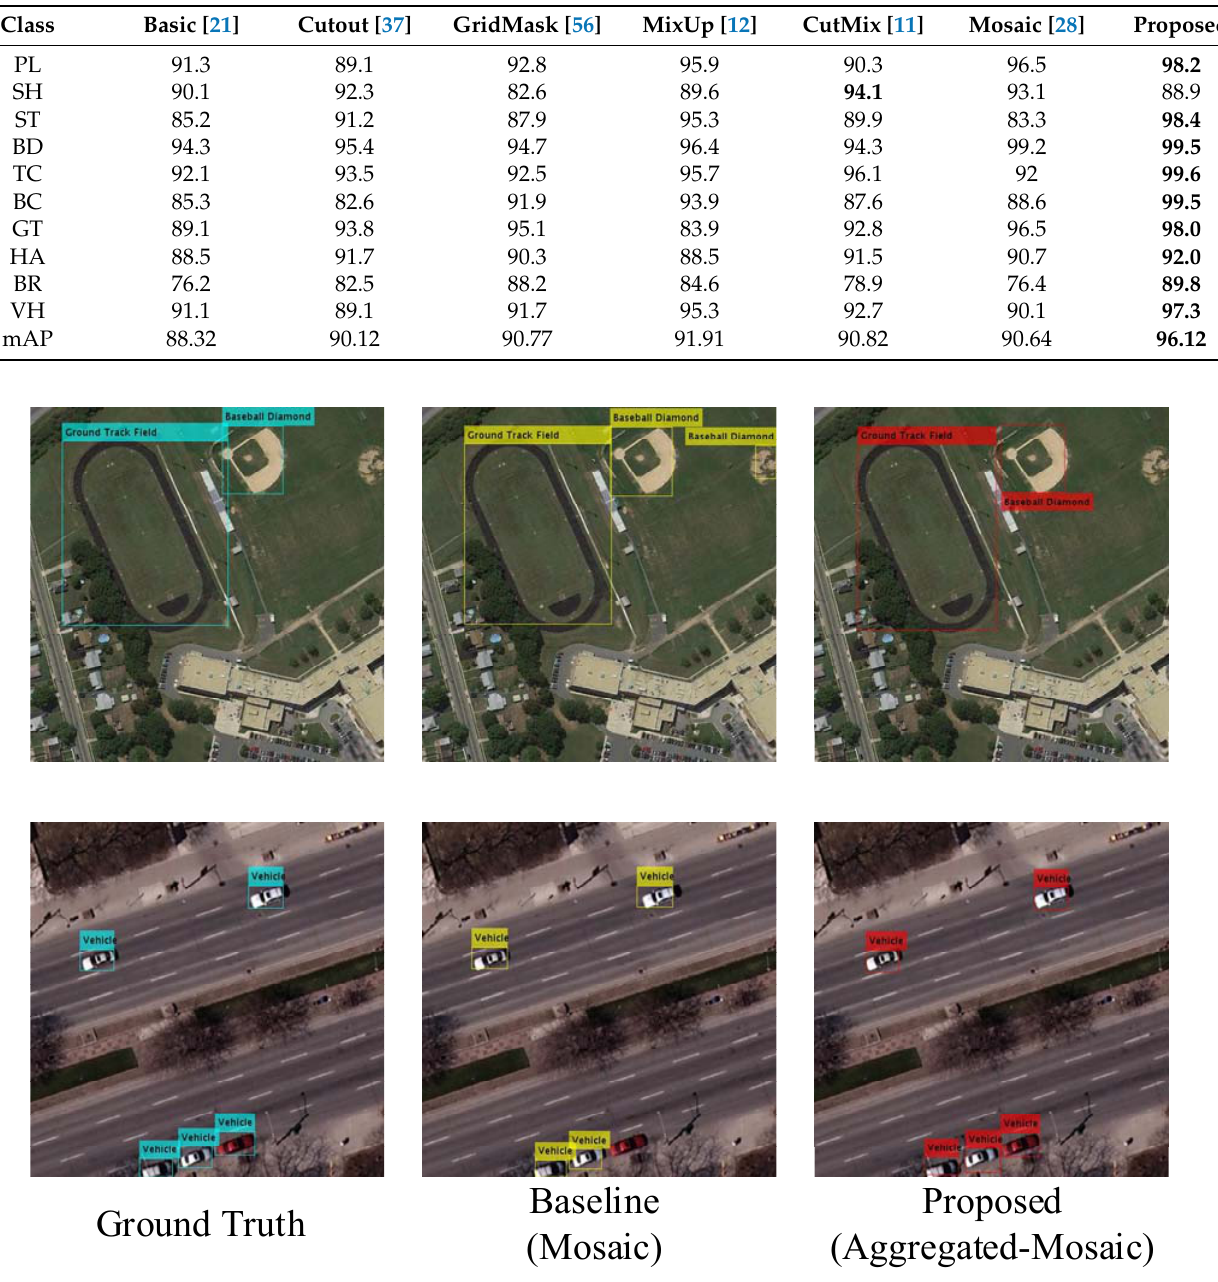
Figure 14. Detection result: Ground Truth ( right ), Mosaic ( middle ), Aggregated-Mosaic ( left